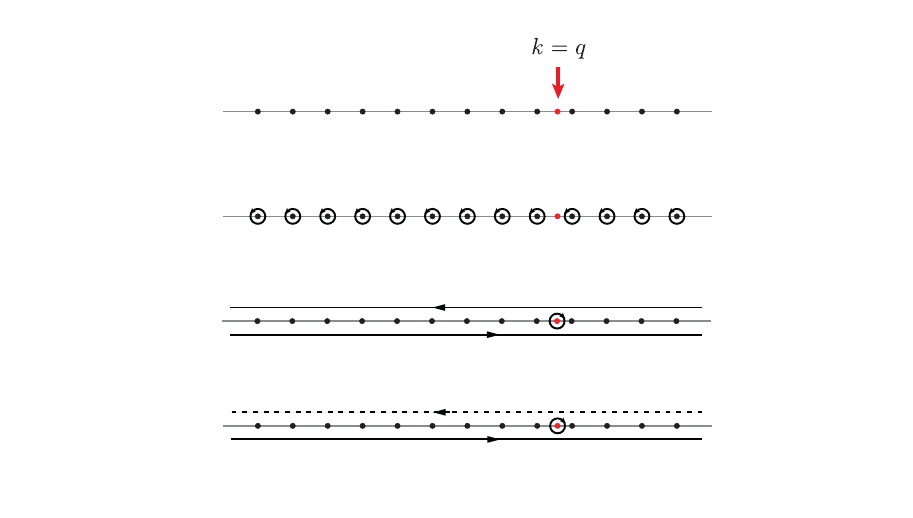
Figure 10: Complex analysis method for the conversion of a sum into an integral in the case of singular